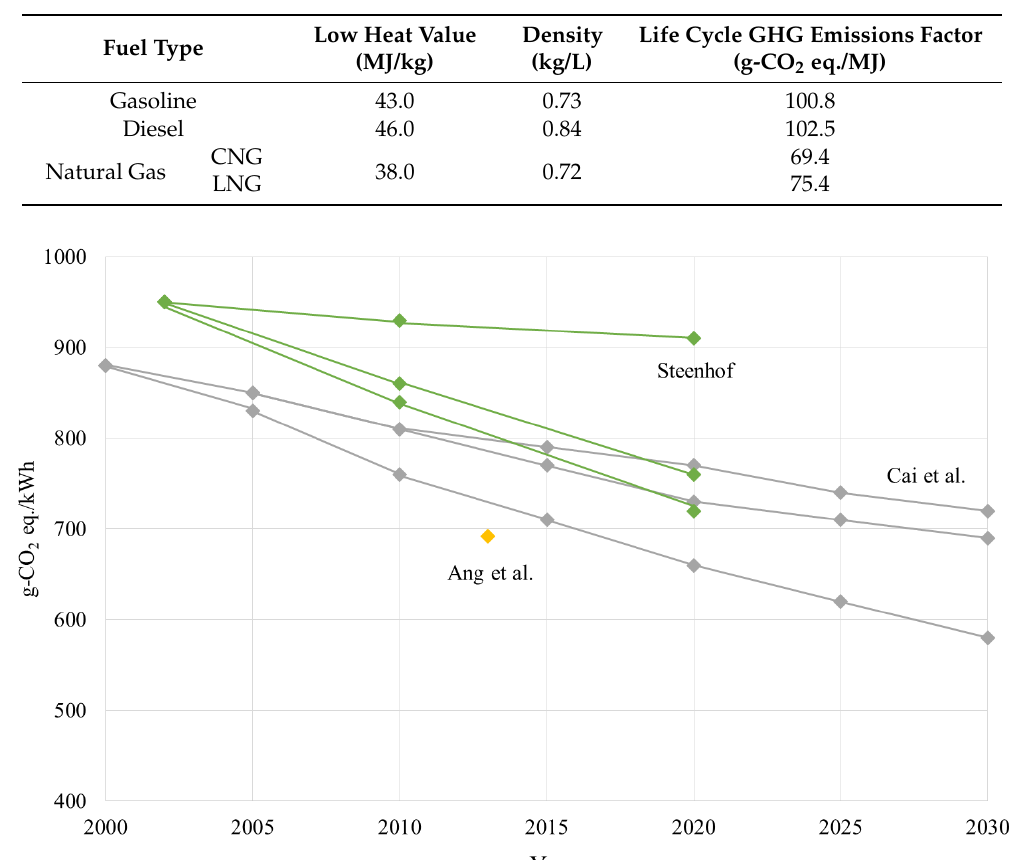
Table 3. Physical properties of vehicle fuels.